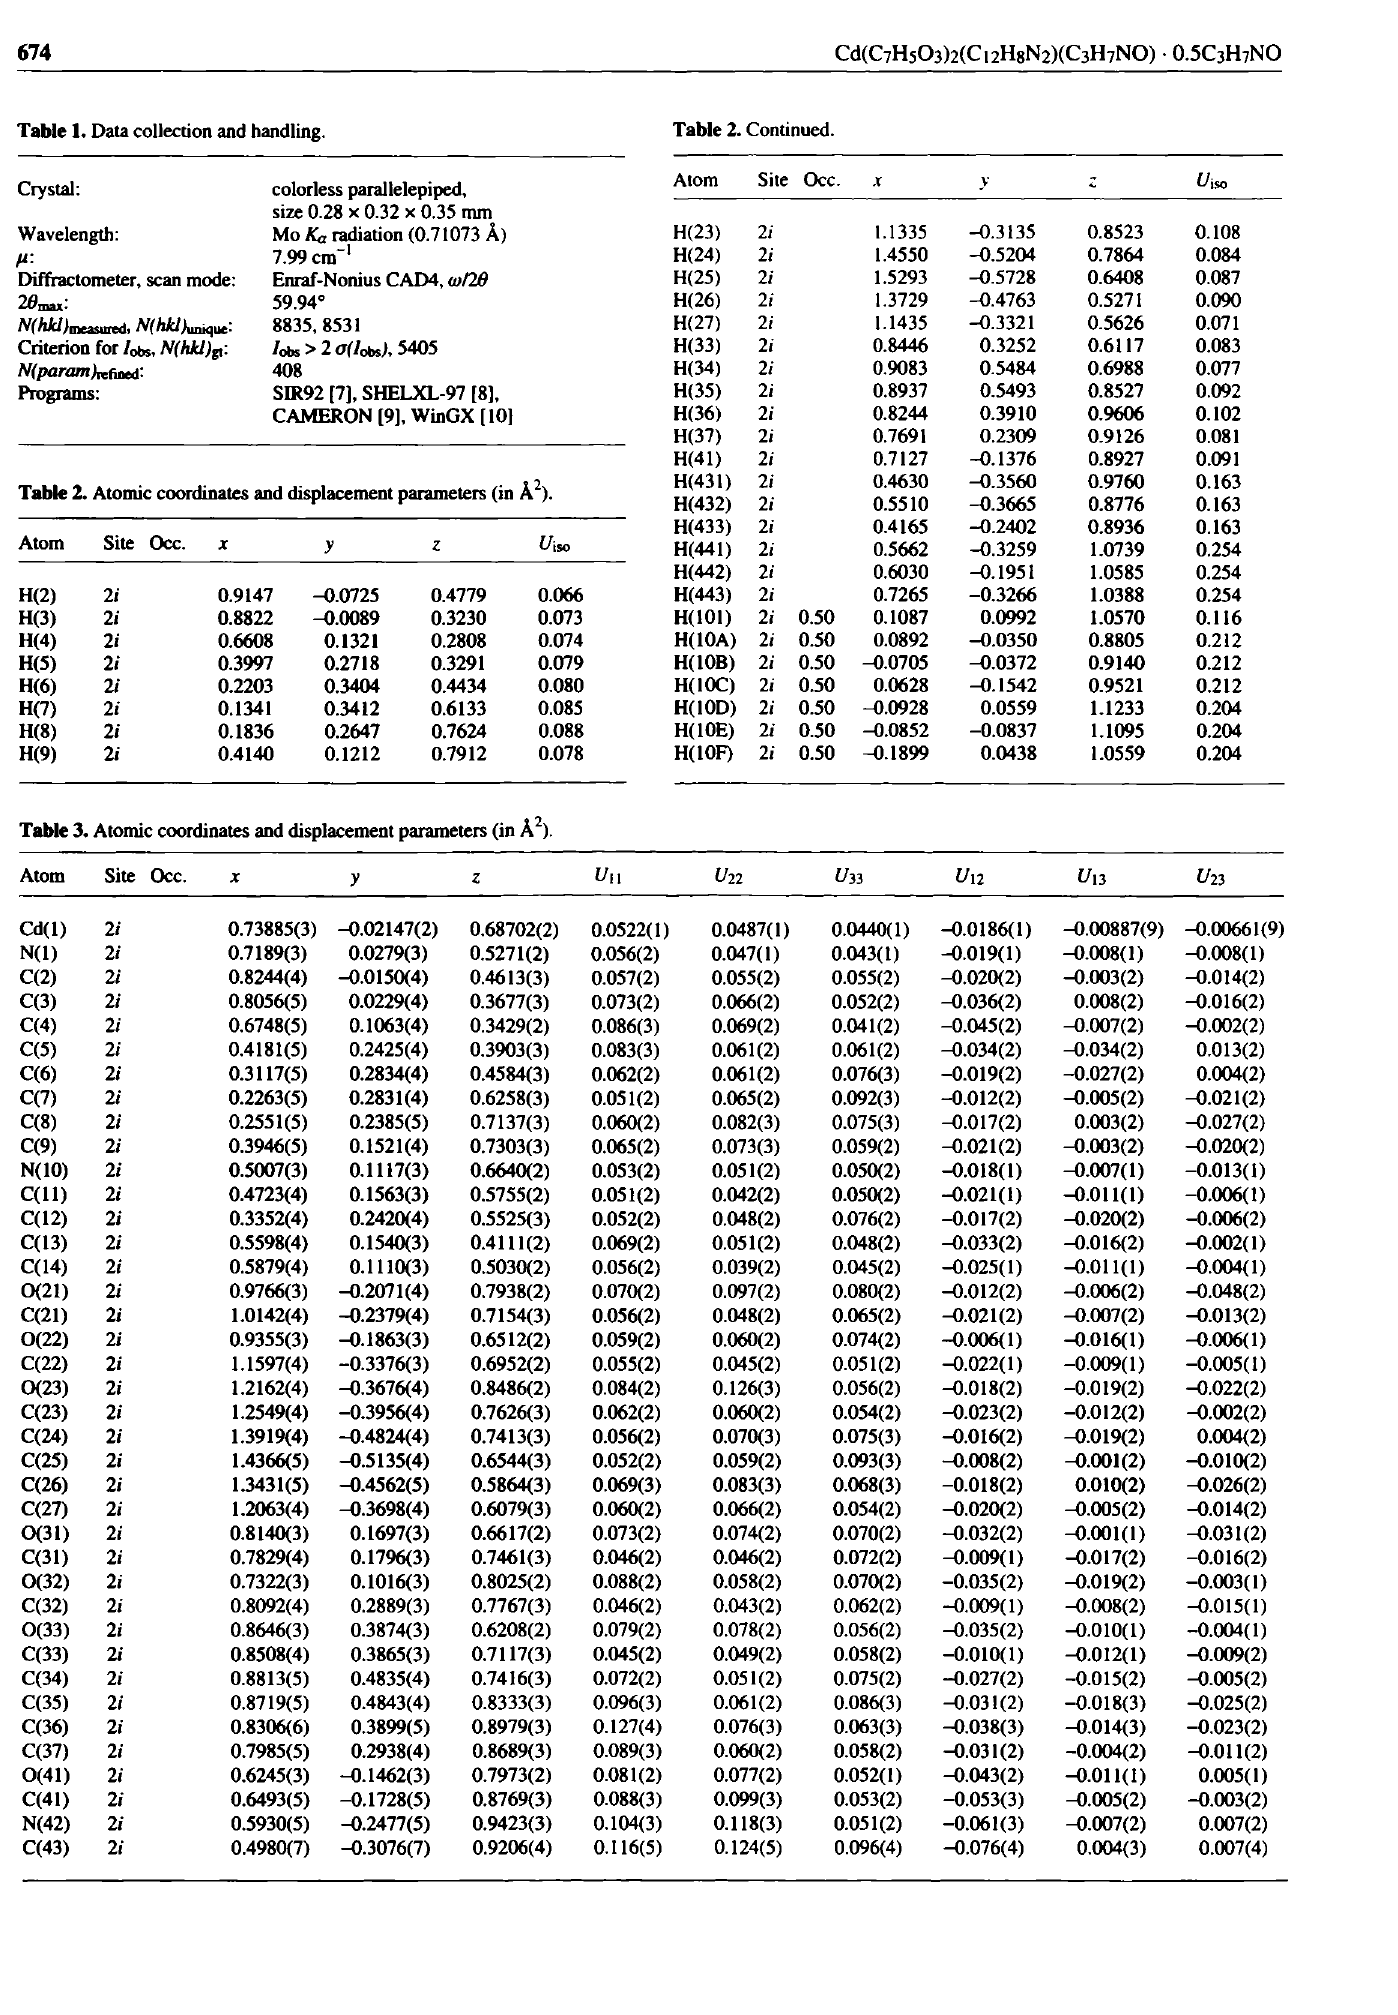
Table 2. Atomic coordinates and displacement parameters (in À 2 ).